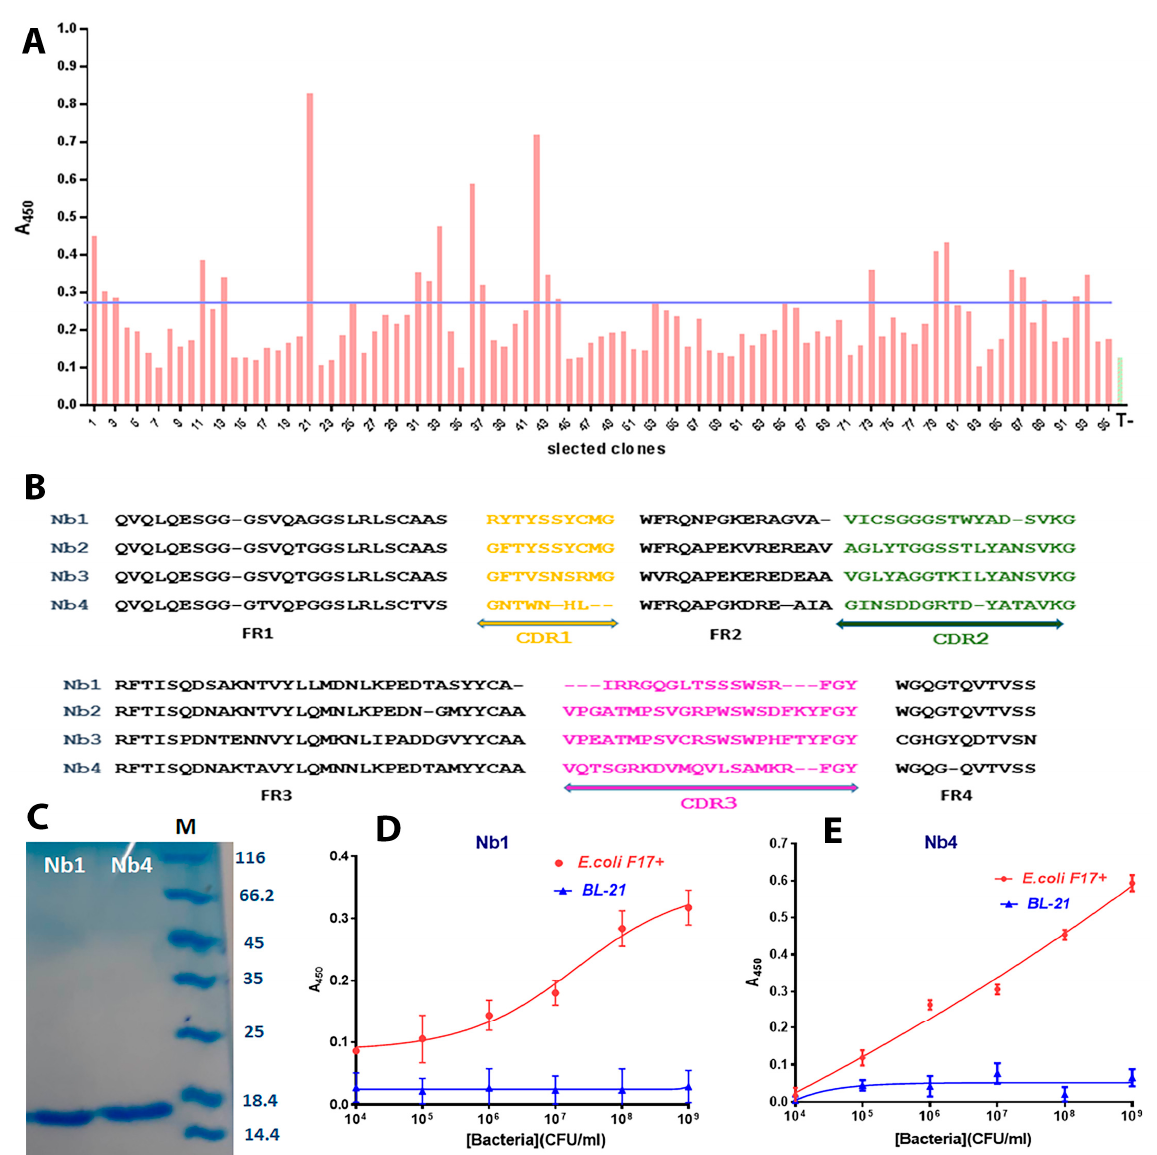
Figure 1. Library screening and nanobody production. ( A ) Monoclonal phage ELISA against the lysate of the F17+ strain. ( B ) Amino acid sequences of the specific anti-F17A nanobodies. CDR designation was performed by a simple alignment with a known nanobody sequence from the Uniprot database. ( C ) SDS-PAGE analysis of purified anti-F17A nanobodies (Nb1 and Nb4) approximately 16 kDa in size. ( D , E ) Indirect ELISA test; Nbs against different concentrations (1 × 10 4 to 1 × 10 9 CFU/mL) of the E. coli F17 and the negative control BL-21 DE3 strains. Analysis of these sequences by bioinformatic tools showed that they belong to four different Nb families sharing the same CDR3 (Cluster of Differentiation) region. The predicted peptide sequences of these Nbs are presented in Figure 1B. The four selected Nbs were subcloned into the expression vector pET28a(+). Nb1 and Nb4 were well expressed and purified by HPLC. After desalting, both recombinant VHHs were highly pure, as deduced from SDS-PAGE (sodium dodecyl sulfate polyacrylamide gel